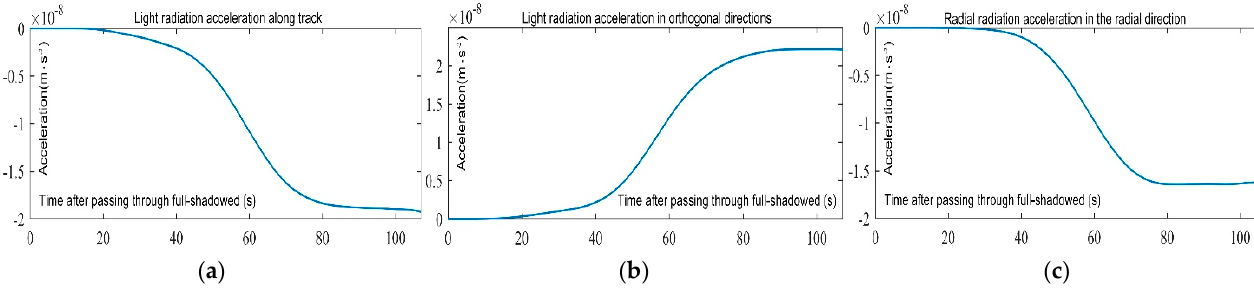
Figure 7. Light radiation acceleration (LRA) when Swarm-C after full-shadowed. ( a ) LRA along the orbit; ( b ) LRA in orthogonal directions; ( c ) LRA in the radial direction.